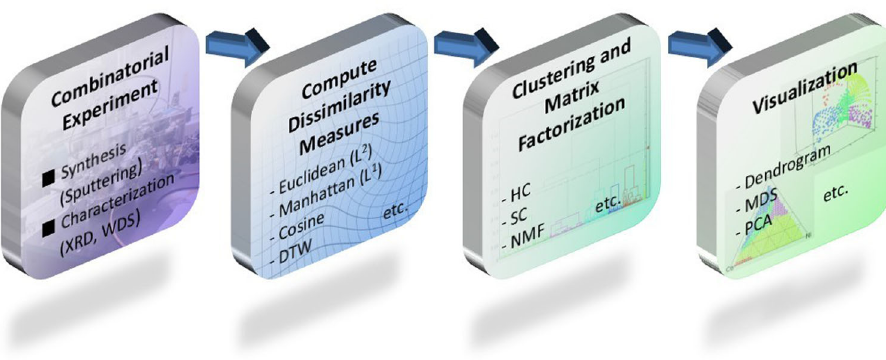
Fig. 1 Composition spread analysis fl ow chart: The strategy begins with the a synthesis of the composition spread and rapid characterization of composition and structure, followed by b computing dissimilarity measures, c composition-phase map determination and constituent phase identi fi cation via machine learning, and d visualization of analysis results via the use of a composition diagram and data dimension reduction techniques applied to the structural